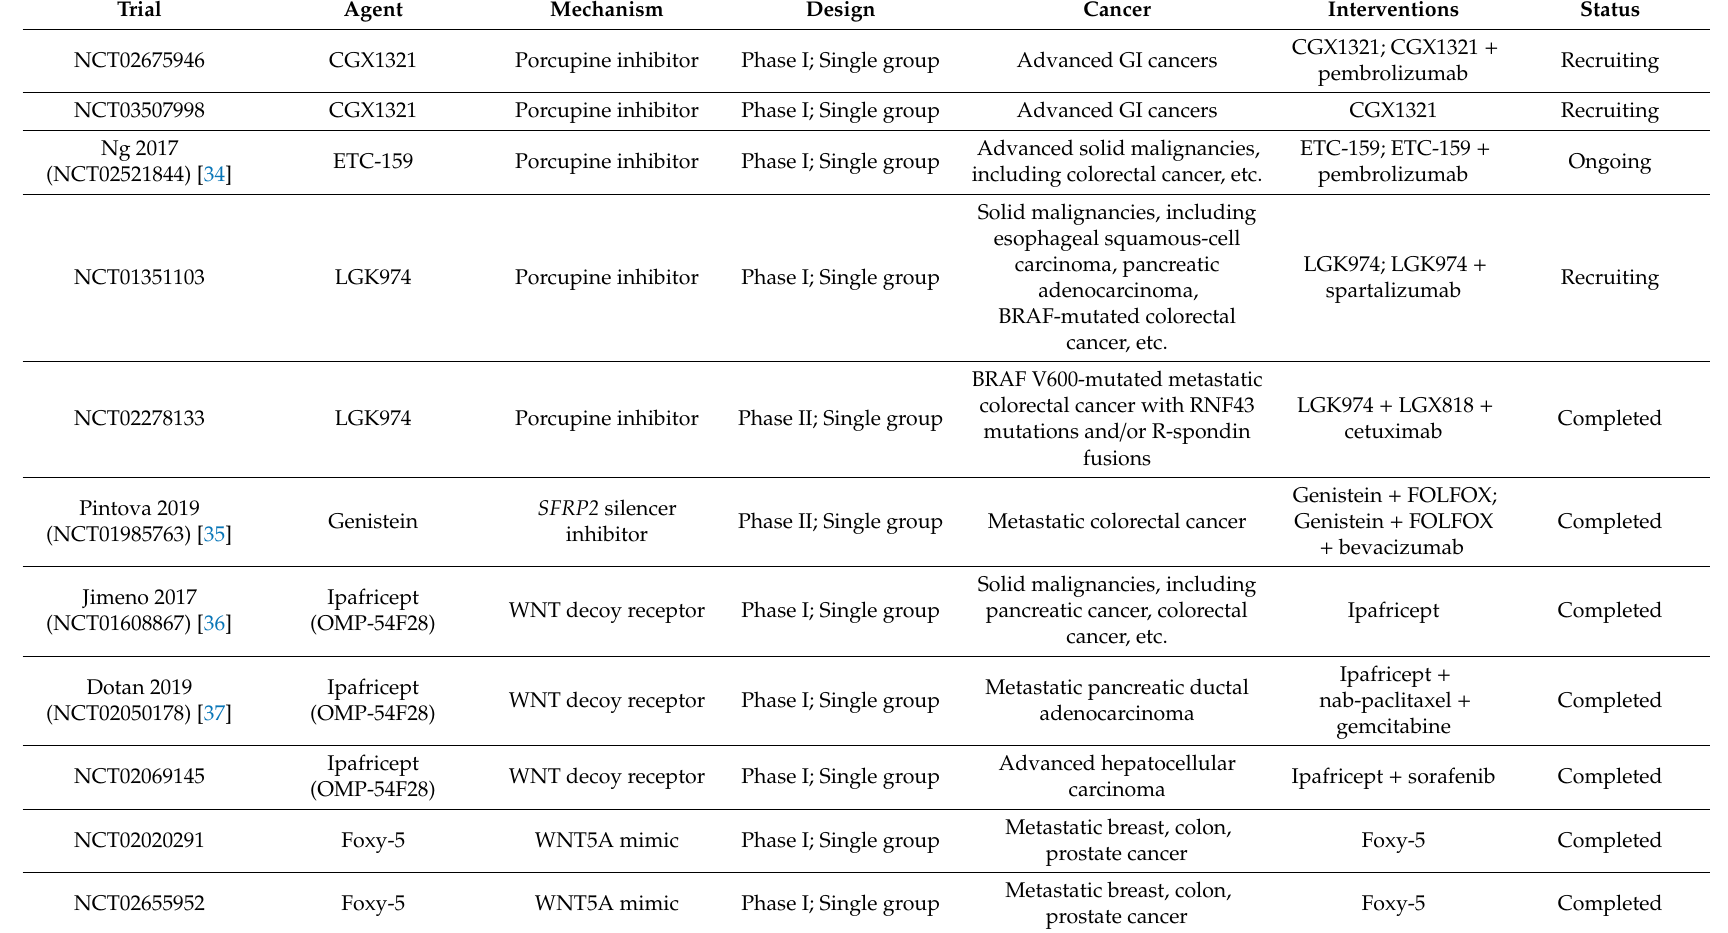
Table 2. Agents inhibiting Wnt signaling for GI cancers in clinical